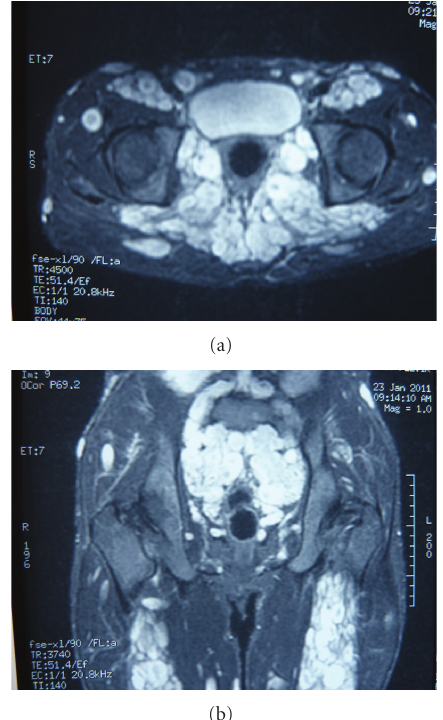
Figure 2: (a) Axial FSE fat-suppressed T2 weighted image shows extensive, conglomerate masses in the pelvis, gluteal region and along the bilateral sciatic nerves. (b) Coronal FSE fat-suppressed T2 weighted image of the same patient demonstrates that neurofibro- mas have a characteristic bright signal intensity on these